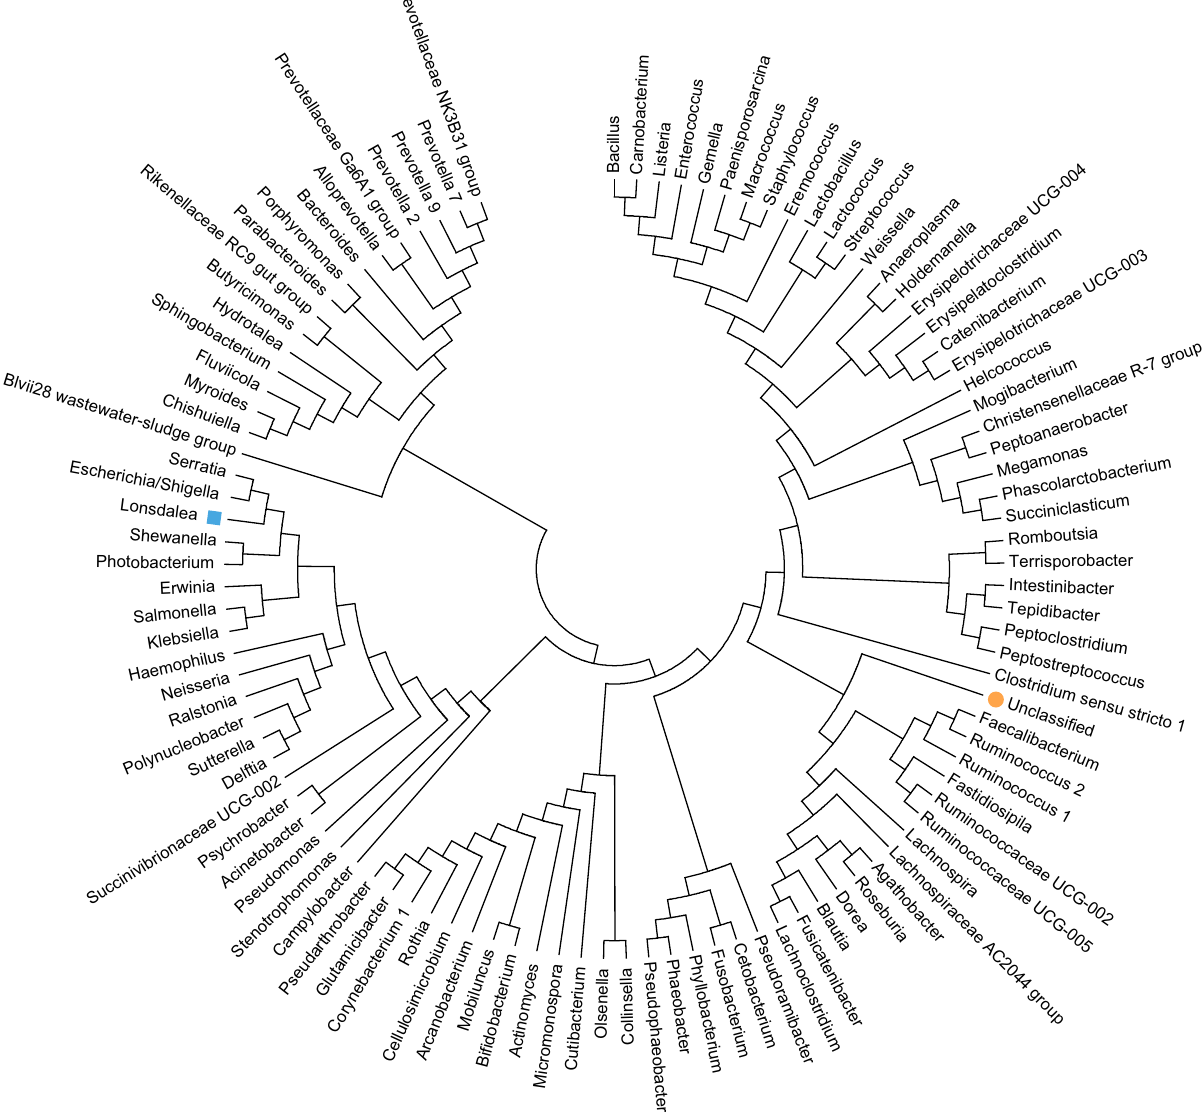
Figure 5. Molecular Phylogenetic analysis of the endometrial microbial community recovered (represented by the most abundant 104 ASVs). The Maximum Likelihood method, based on Tamua-Nei model, was used to infer the evolutionary relationships. A set of probable tree topologies were inferred from a Maximum Composite Likelihood (MCL) pairwise distance matrix, using Neighbor-Join and BioNJ algorithms. The illustrated tree is the one with the highest log likelihood. All pertaining analyses were conducted using MEGA7 65